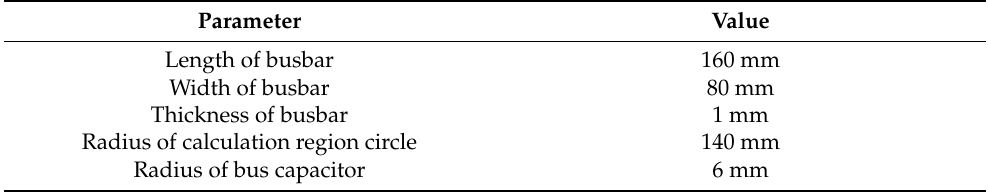
Table 1. Key parameters and exploitation of the ANSYS model.